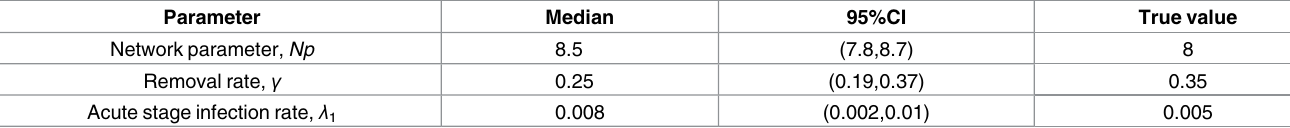
Table 2. Parameterestimation for one epidemic spread on an ER